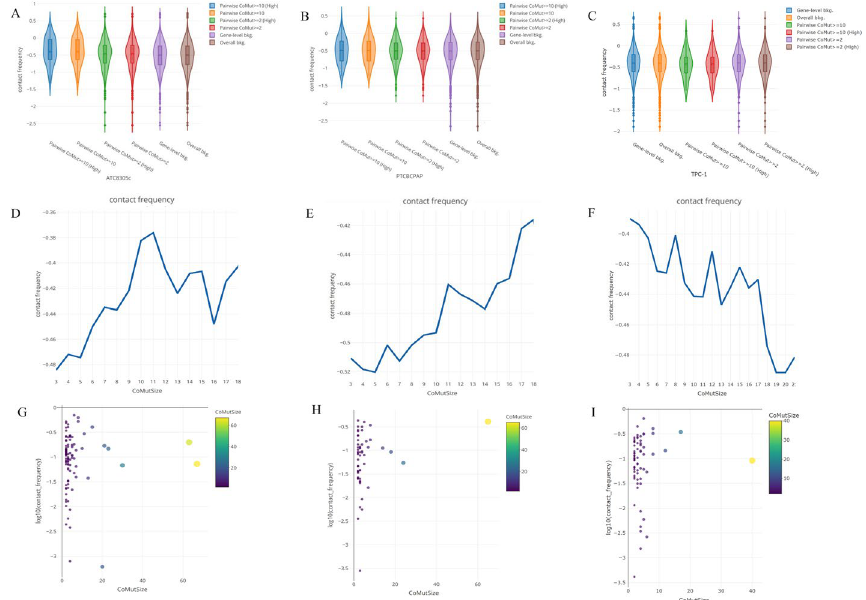
Fig. 1 A – C Spatial proximity of co-mutated gene pairs. Violin plots of the contact frequency distribution of the TAD with various levels of CoMut (high), somatic filtering criteria or on background of gene level or overall level in A ATC (8305c), B PTC (BCPAP) and C PTC (TPC-1) cells, based on Hi-C data. D – I Spatial proximity of co-mutated gene pairs in TAD. The contact frequency distribution of various CoMut hotspot mutation counts in TAD in ( D ) ATC (8305c), ( E ) PTC (BCPAP), and ( F ) PTC (TPC-1) cells, based on Hi-C data; the contact frequency scatter plot on various CoMut hotspot mutation counts in ( G ) ATC (8305c), ( H ) PTC (BCPAP), and ( I ) PTC (TPC-1) cells based on Hi-C